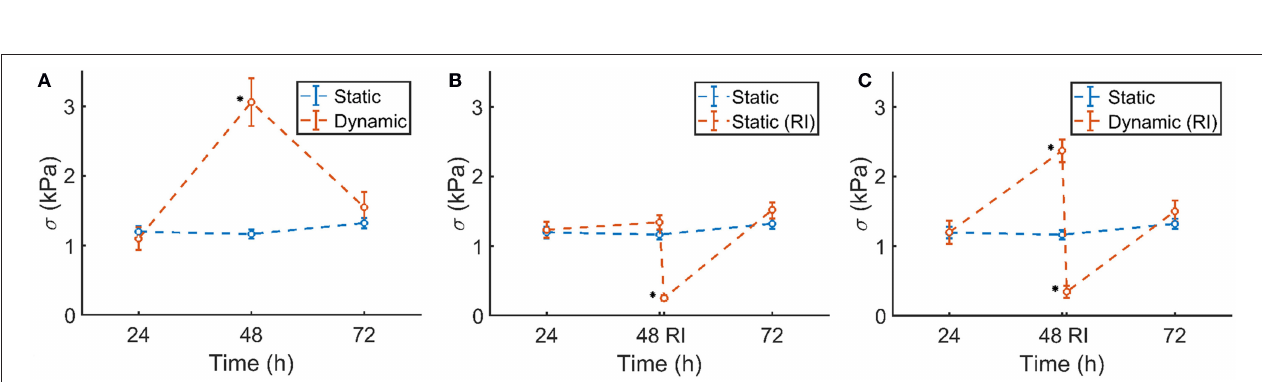
Frontiers in Bioengineering and Biotechnology |